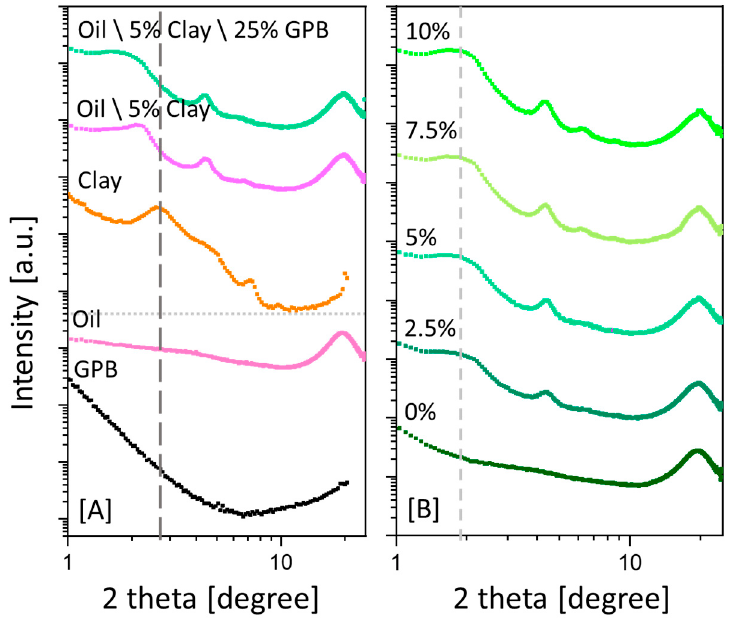
Figure 7. ( A ) X-ray scattering curves of thickened oil loaded with clay and GPB fillers, indicating oil intercalation between the galleries of the clay. The dashed line denotes the major clay reflection as a reference. The scattering curves of the oil and GPB alone (bottom) are presented as a reference. The major oil reflection (19.6°) refers to the hydrogen bond interactions that are not affected by the addition of the different fillers. ( B ) X-ray scattering curves showing that the concentration of the clay (at fixed 25 wt% GPB) did not affect its d-spacing: the major reflection of the swollen clay is denoted by a dashed line. All scattering curves were measured immediately after preparation.